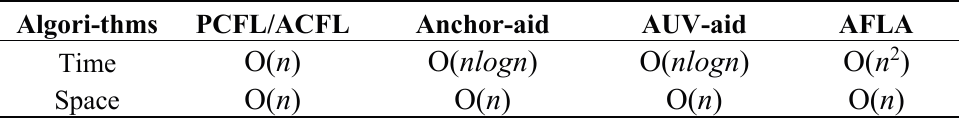
Table 2. Comparison of worst case time.